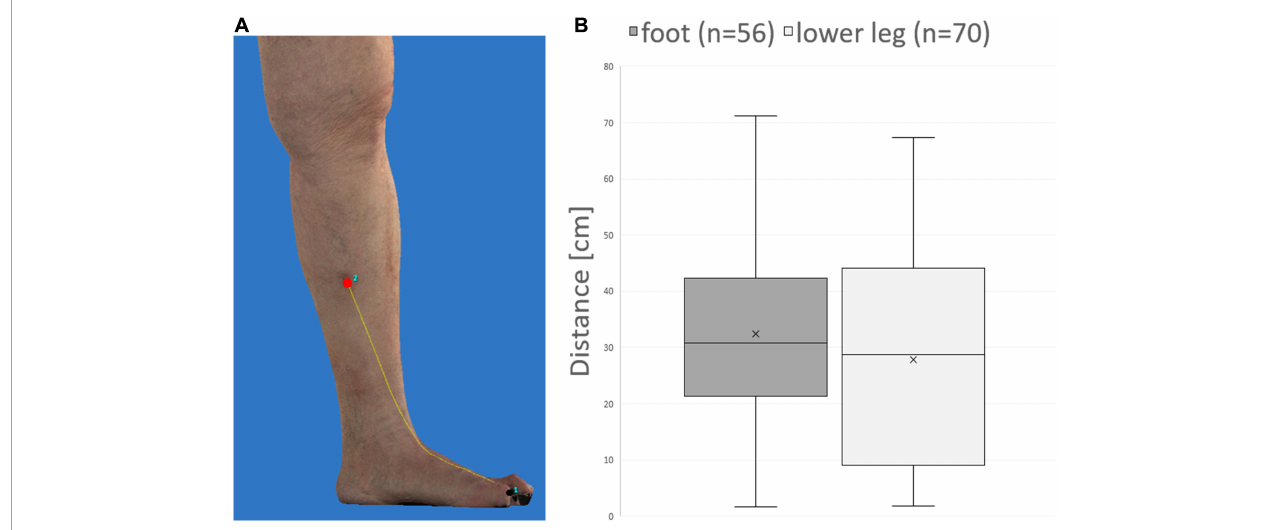
FIGURE3 Distance measurement of primary melanoma and in-transit metastases on three-dimensional (3D) photography. (A) Example demonstrating measurement of the distance (yellow line) along the skin surface between primary melanoma (black) and an in-transit metastasis (red). (B) No significant difference between melanoma of the foot compared to the lower leg is detectable concerning mean, median, and range of distances between melanoma and corresponding in-transit metastases.